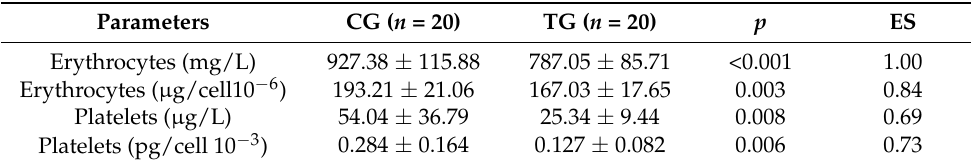
Table 6. Fe concentration in intracellular compartments.